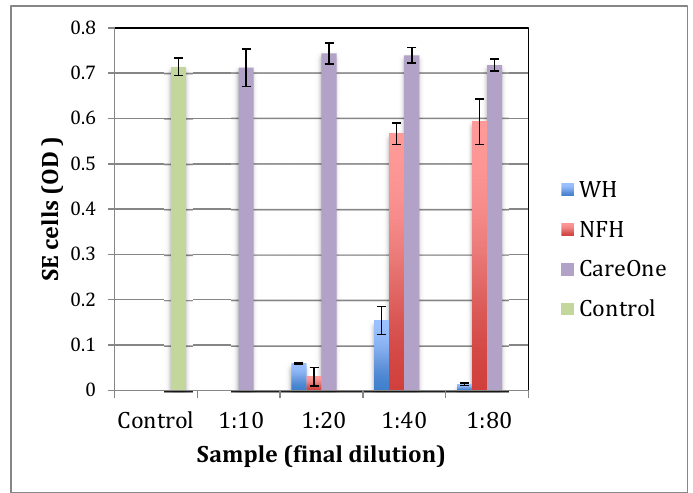
Figure 1. The effect of witch hazel extracts on the growth of S. epidermidis. Bacteria were grown overnight in TSB in the presence of increasing amounts of witch hazel extracts, ethanol, or culture broth alone (control). OD 630 was determined after 24 h. Witch hazel extracts tested: WH (whISOBAX, StaphOff Biotech), CareOne extract (CareOne), and NFH (Nutritional Fundamentals for Health).